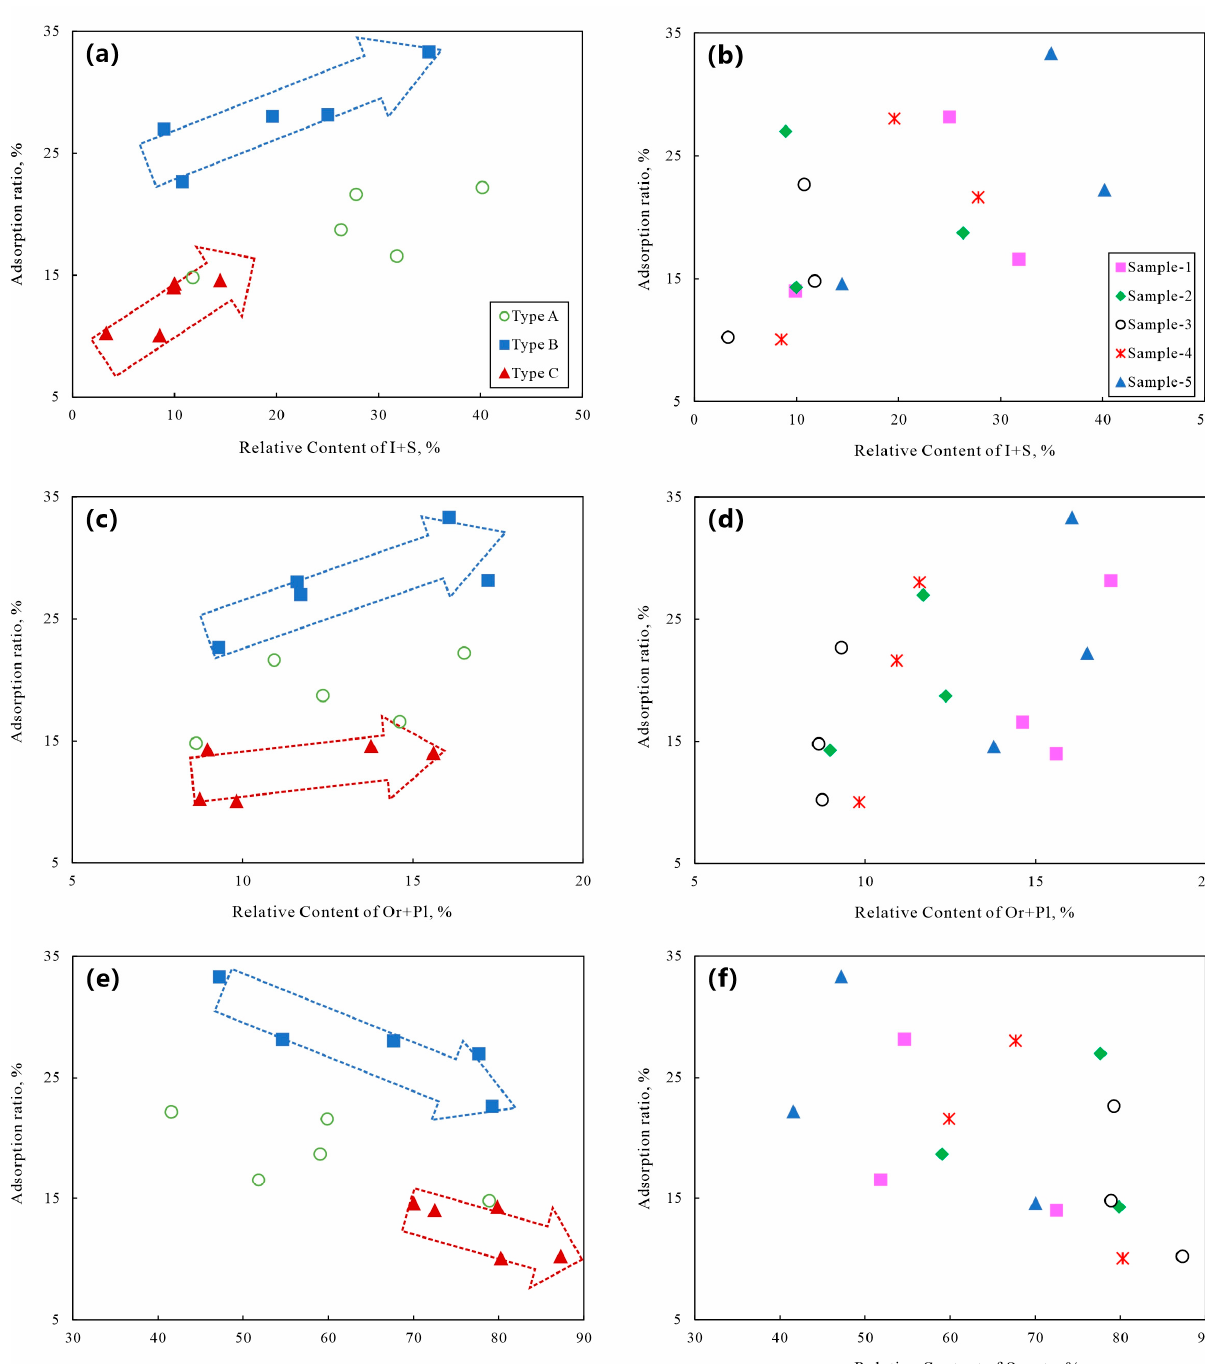
Figure 6. Relationship between the adsorption ratio of crude oil and the relative content of minerals. The adsorption ratio of crude oil and relative content of I + S ( a ), Or + Pl ( c ), Quartz ( e ) of three types of adsorbent (T A , T B , and T C ); The adsorption ratio of crude oil and relative content of I + S ( b ), Or + Pl ( d ), Quartz ( f ) of five types of shale adsorbent (Sample ‐ 1, Sample ‐ 2, Sample ‐ 3, Sample ‐ 4, Sample ‐ 5).